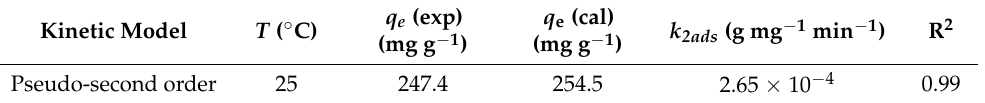
Figure 7. The kinetic fitting diagram of uranium adsorbed by NiCo 2 O 4 /MWCNT at 25 °C. Table 1. Kinetic parameters of uranium adsorption by NiCo 2 O 4 /MWCNTs.